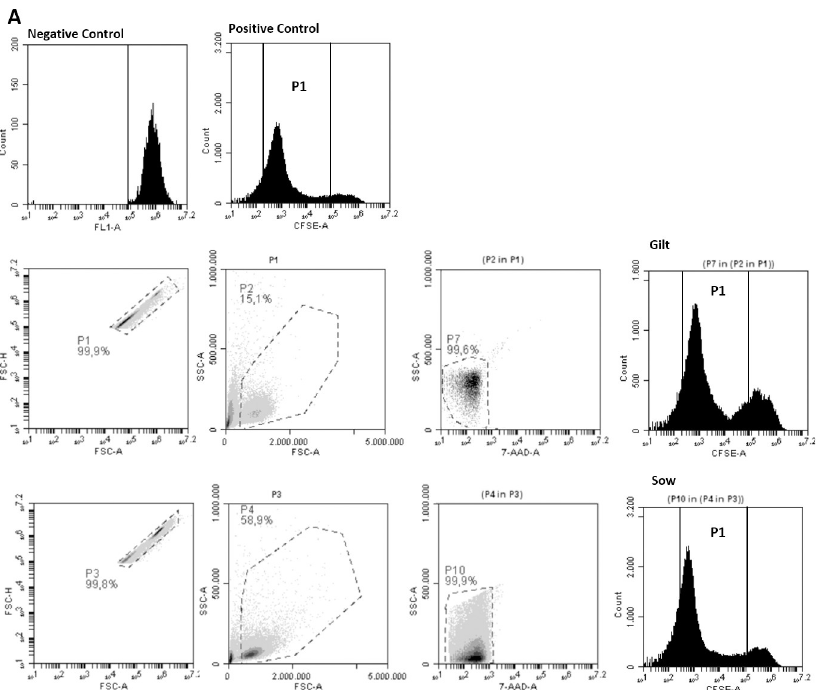
Fig 4. Dot plots and histograms representative of an IEC-6 proliferation assay using CFSE. IEC-6 cells (1x10 6 cells/ mL) were labeled with CFSE (2.5 μ M) and cultured in 24-well plates with colostrum (100 μ L) from sows and gilts, positive control with added FBS, and negative control without FBS. Cells were recovered after cultivation for 48 hours and evaluated for CFSE staining intensity. Live, singlet cells were gated using forward scatter properties (FSC-H and FSC-A). The P1 regions represent the IEC-6 cell division profile compared with negative control. Colostrum T lymphocytes expressing activation markers are a definite cell population that shows phenotypical differences from those found in peripheral blood [12,13]. They express in vitro functional capabilities, e.g. response to bacterial and viral antigen stimulation. Our results